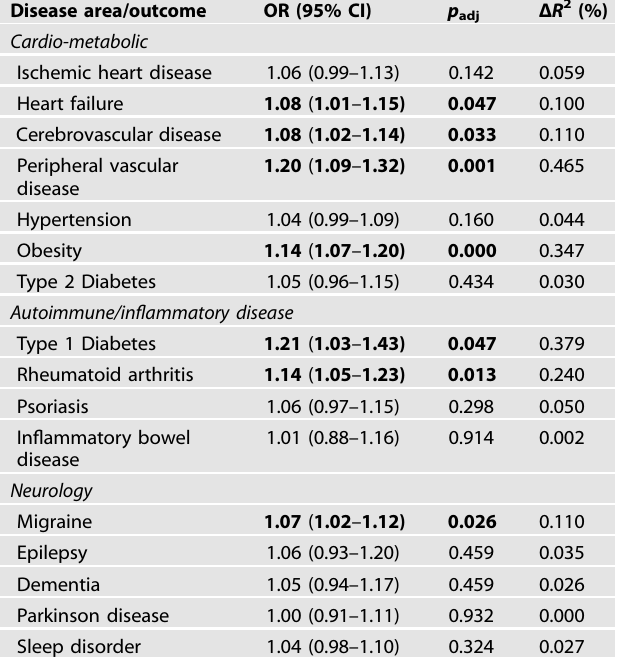
Table 2 present associations between ADHD-PRS and somatic health outcomes de fi ned by combined register and self-reported data. Associa- tions by each ascertain source separately are presented in Fig. S1. Bolded estimates display signi fi cant false-discovery rate adjusted p -values. PRS polygenic risk score, OR odds ratio, CI con fi dence interval, P adj false- discovery rate adjusted p -values. Δ R 2 difference in Nagelkerke pseudo- R 2 expressing the percentage variance explained by ADHD-PRS in the